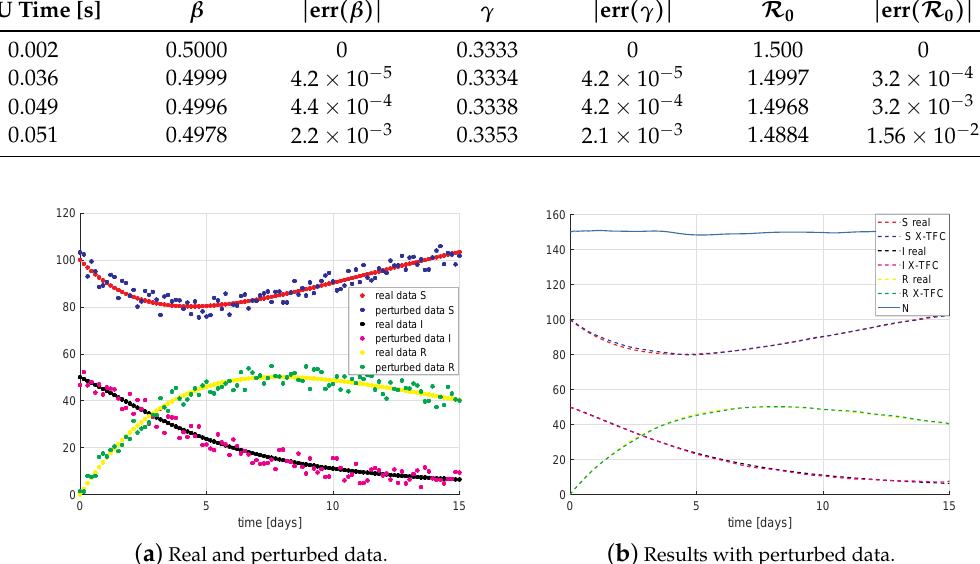
Table 1. Performances of the proposed physics-informed framework in the data-driven discovery of the SIR model with different noise on the data, with n = 100 and L = 50. Noise